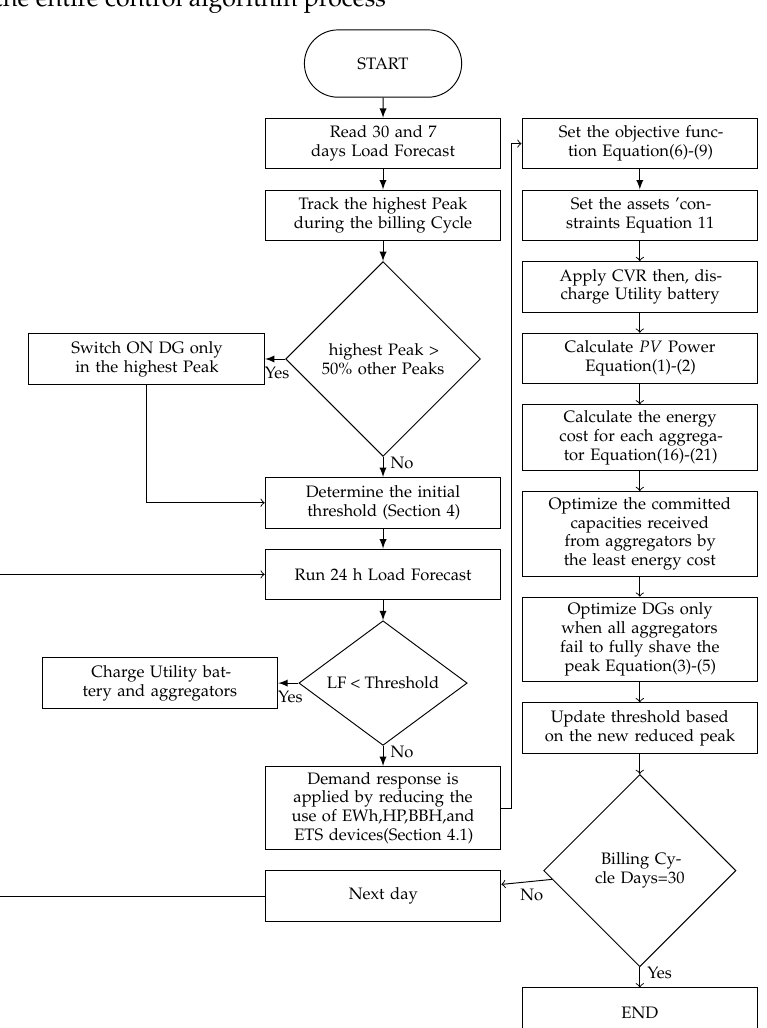
Figure 2. Flowchart of the proposed